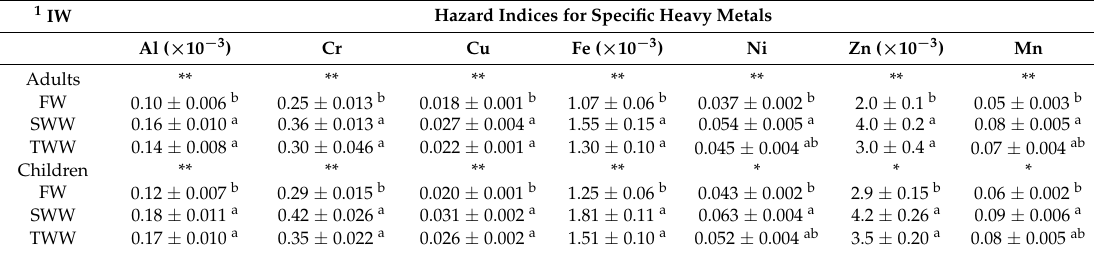
Table 6. Main effects of the type of irrigation water used in artichoke cultivation on hazard indices for specific heavy metals. The hazard indices were calculated to define the exposure to non-carcinogenic risk in terms of the estimated consumption of artichoke heads by adults and children. The data shown are the means ± standard errors for each heavy metal and were determined on 6 samples for each water source (3 replicates × 2 growing